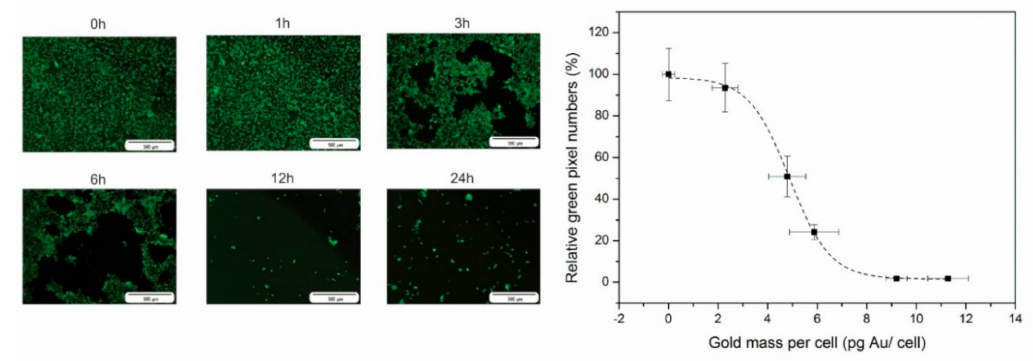
Figure 5. Left : Fluorescence images of the living cells after photothermal therapy (PTT) using calcein AM staining for tumor cells (n = 3) incubated for di ff erent time periods with the nanostars. Right : Relative green pixel numbers plotted against the gold mass per cell. Fluorescence signal intensity is expressed relative to the unlabeled control cells (0 h).